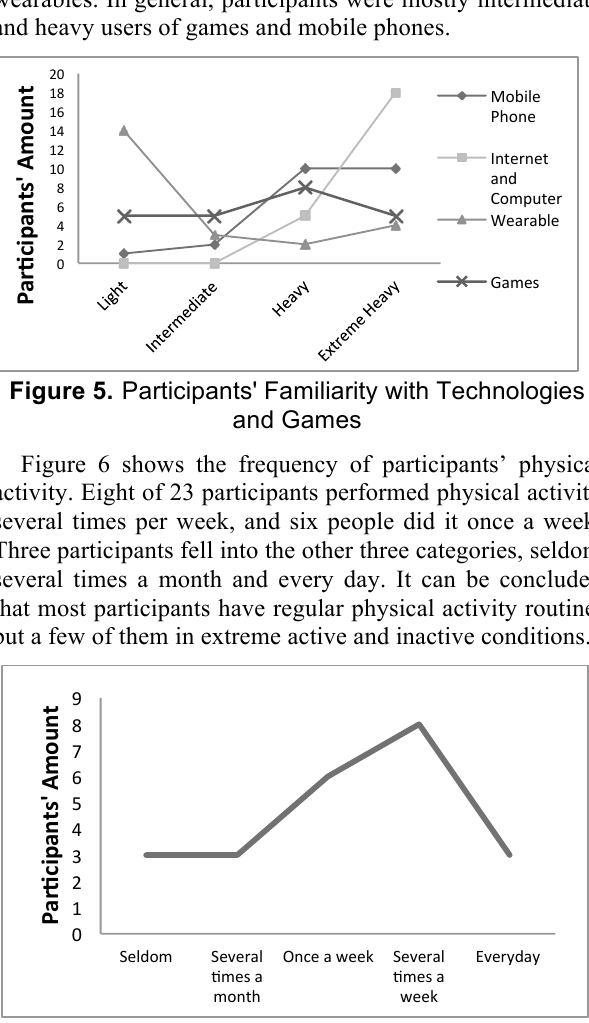
Figure 6. Participants' Frequency of